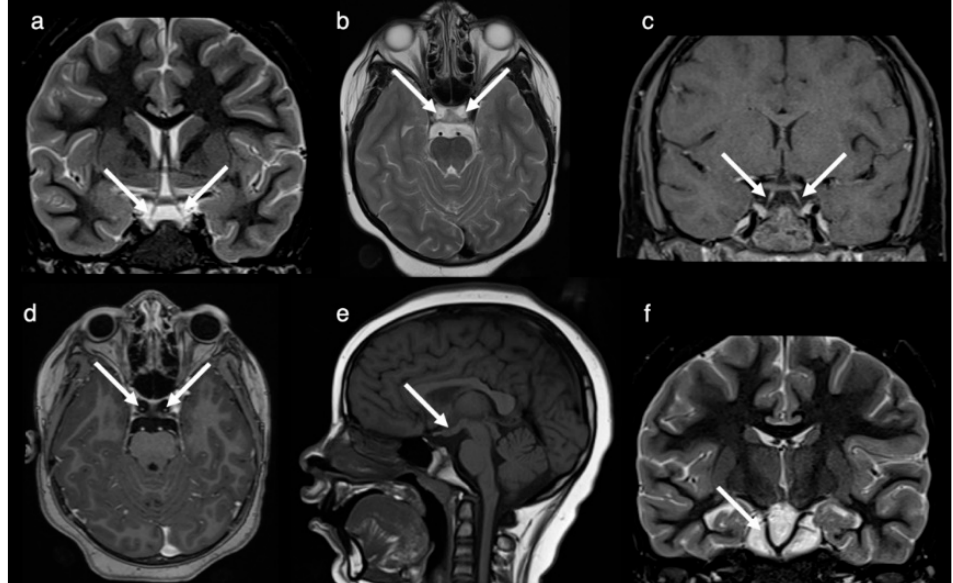
Figure 2. Brain MRI images obtained at 8 years of age. Coronal T2-weighted short-tau inversion recovery (STIR; ( a )), axial T2-weighted ( b ), coronal fat saturated T1+C-weighted ( c ) and axial T1+C- weighted ( d ) MR-images demonstrate the complete duplication of the pituitary gland including the pituitary stalk (arrows in ( a – d )). Sagittal T1-weighted MR-image ( e ) documents the tuberomammillary fusion (arrow). Coronal T2-weighted STIR image ( f ) shows the duplication/low bifurcation of the basilar artery (arrow) at the midpons level with the distal basilar artery supplying the superior cerebellar and posterior cerebral arteries.